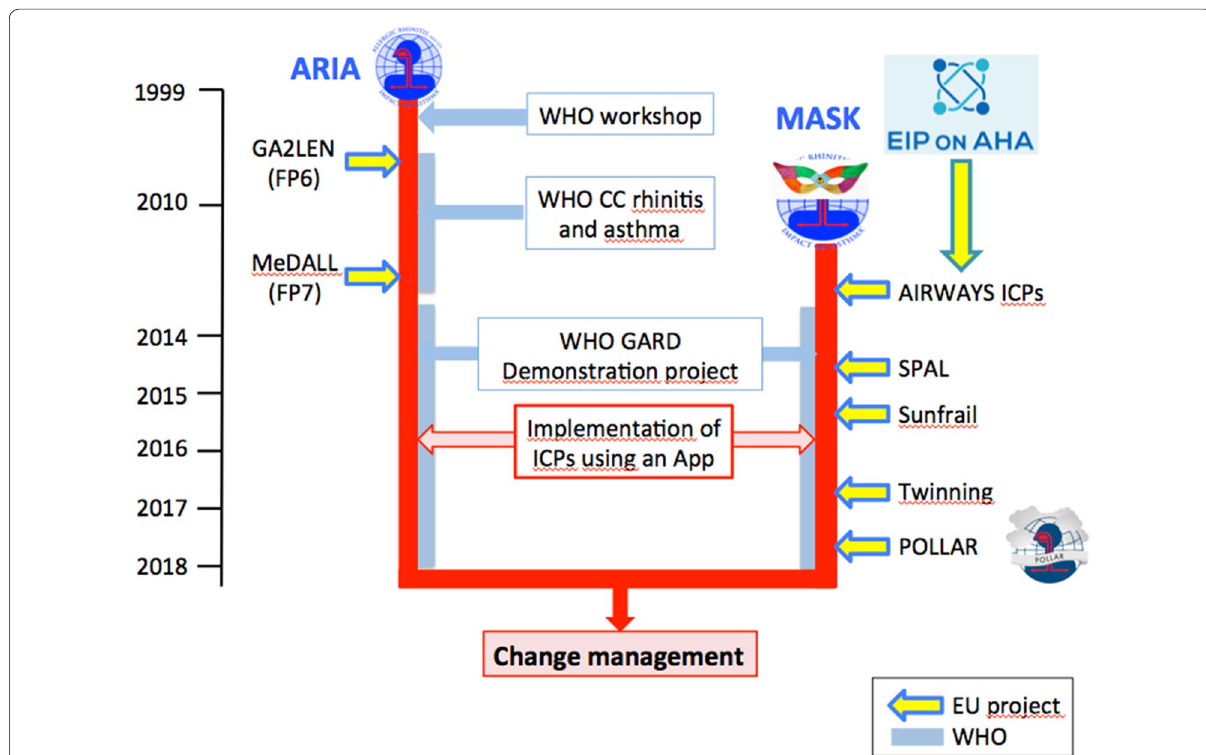
Fig. 1 Links between ARIA and MASK for change management. CC Collaborating Center, GA 2 LEN Global Allergy and Asthma European network, GARD Global Alliance against Chronic Respiratory Diseases, MeDALL Mechanisms of the Development of ALLergy, POLLAR Impact of air POLLution on sleep, Asthma and